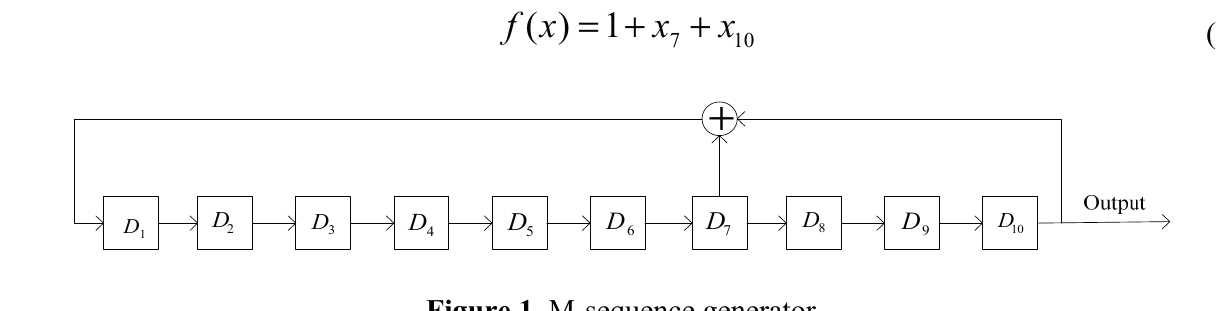
Figure 1. M-sequence generator.